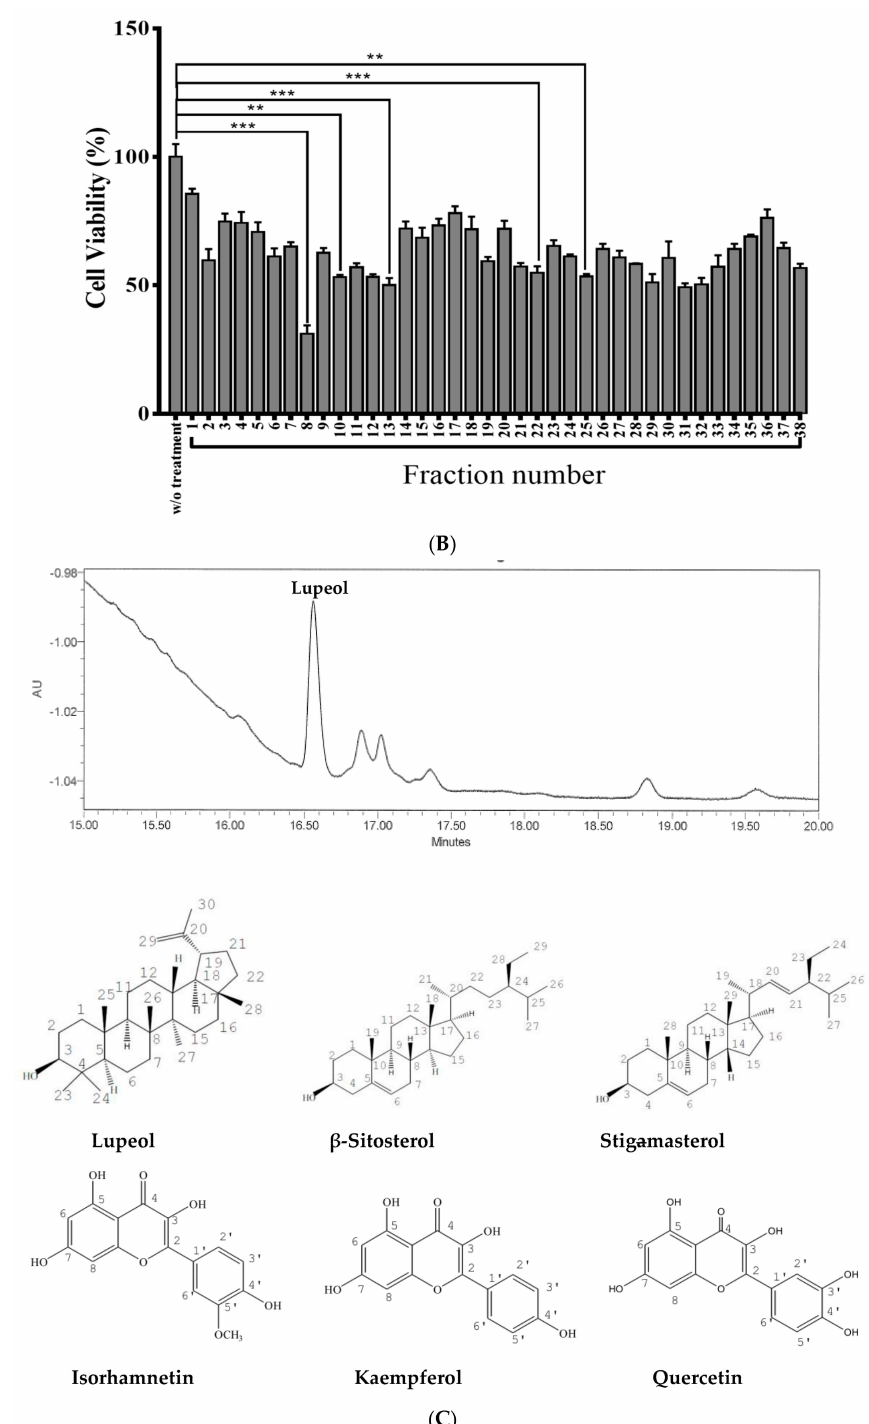
Figure 1. Isolation and cytotoxicity of Apocynum venetum L. (AVL) ethanolic extracts: ( A ) Flow chart of the AVL extraction process (H: hexane; E: ethyl acetate; M: methanol; N/A: not applicable); ( B ) The cytotoxicity of fractions on PC3 cell viability (250 µ g/mL). Cell viability was determined by MTT (3-(4,5-cimethylthiazol-2-yl)-2,5-diphenyl tetrazolium bromide) assay (3 × 10 4 cells/well, incubated with Ham’s F-12K medium with 10% Fetal Bovine Serum, (FBS). MTT assay was detected at 570 nm; ( C ) Chromatogram of 10E90H-4 and chemical structures of isolated phytocompounds from AVL leaves ethanolic extracts. The absorbance was recorded at 210 nm. All data are expressed as the means ± standard deviation (SD) of at least three replicates ( n ≥ 3). ** p < 0.05; *** p <